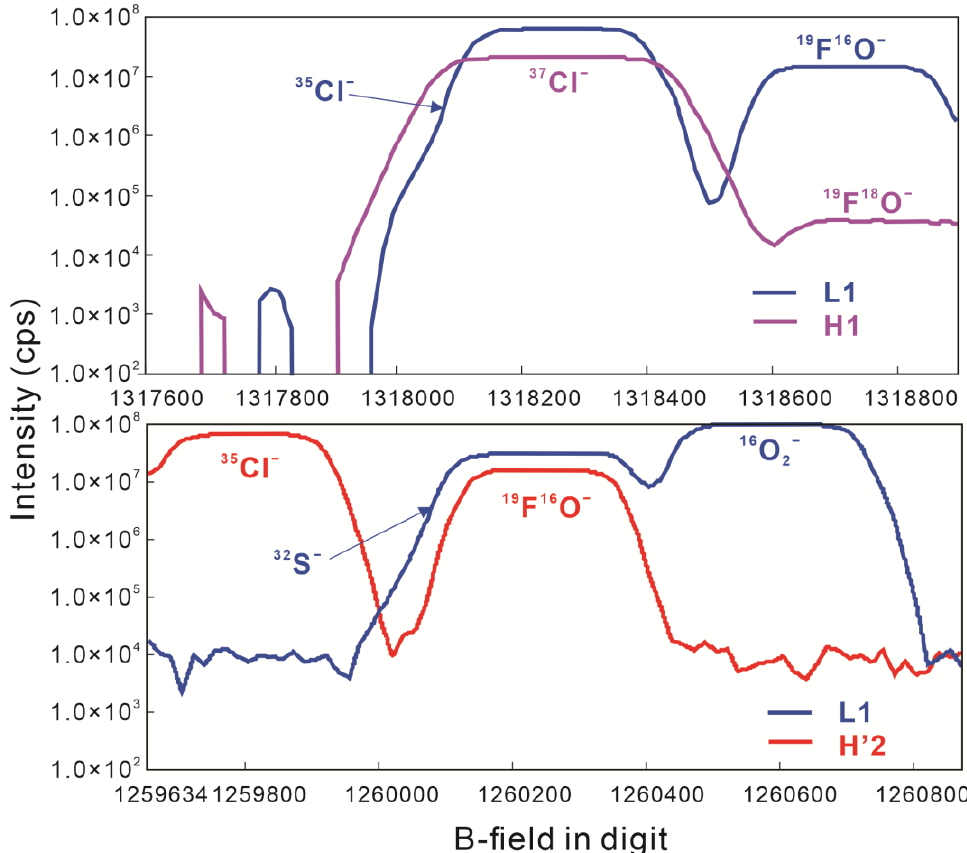
Figure 1. Mass spectrum of 35 Cl − , 37 Cl − , 19 F 16 O − , and 32 S − on apatite determined using SIMS.